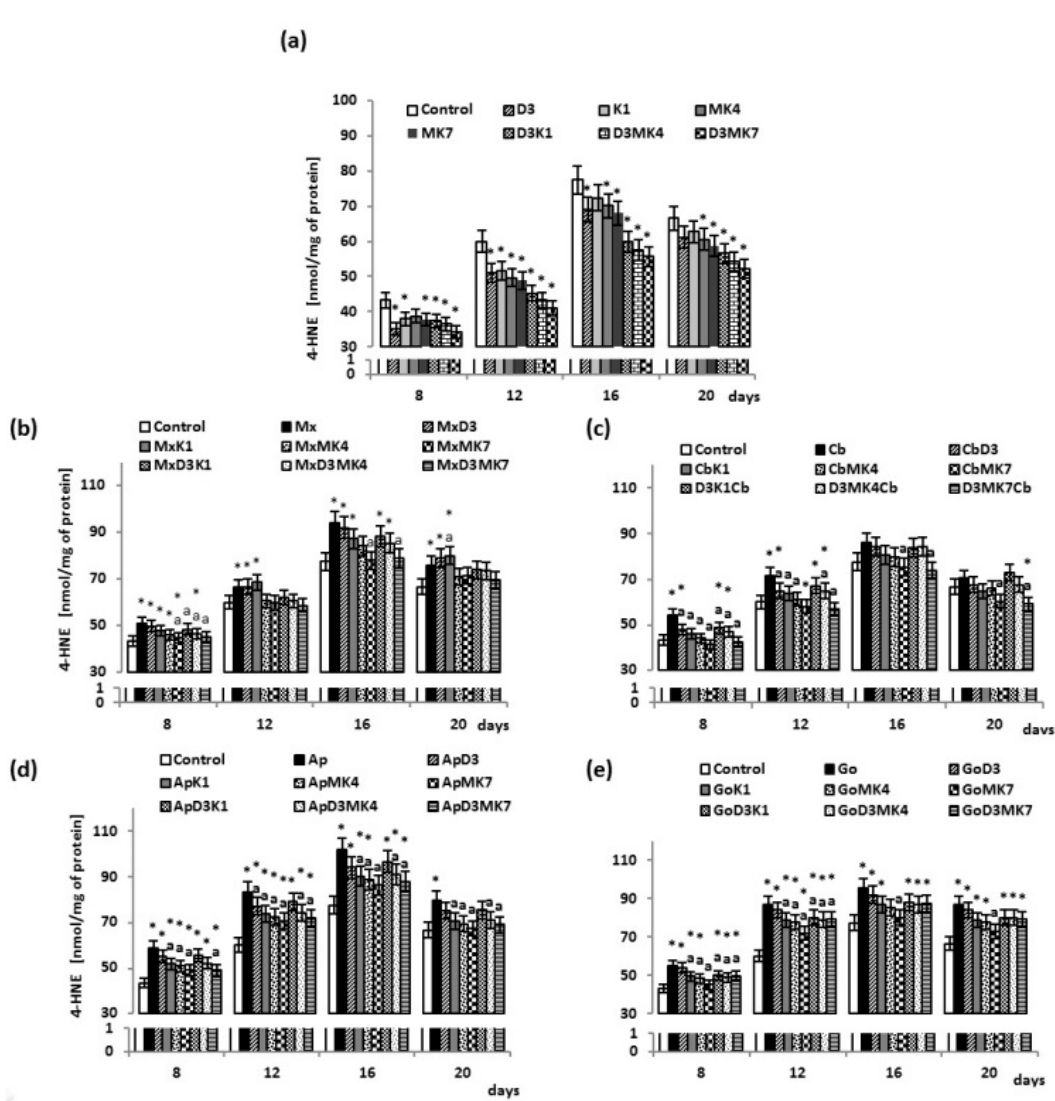
Figure 4. 4-HNE level in osteoblasts after incubation with hydroxyapatites and treated with vitamins D3, K1, MK4, and MK7 after 8, 12, 16, and 20 days. The results are expressed as the nmol/mg of protein and are shown as the mean ± SD ( n = 5). The values for the control cells and the treated cells were significantly different according to unpaired Student’s t -test. * Statistically significant differences versus control. p < 0.05; ( a ) statistically significant differences versus group hydroxyapatites (Mx (Maxgraft), Cb (Cerabone), Ap (Apatos), Go (Gen-Os), respectively for graphs ( b – e )), p < 0.05.